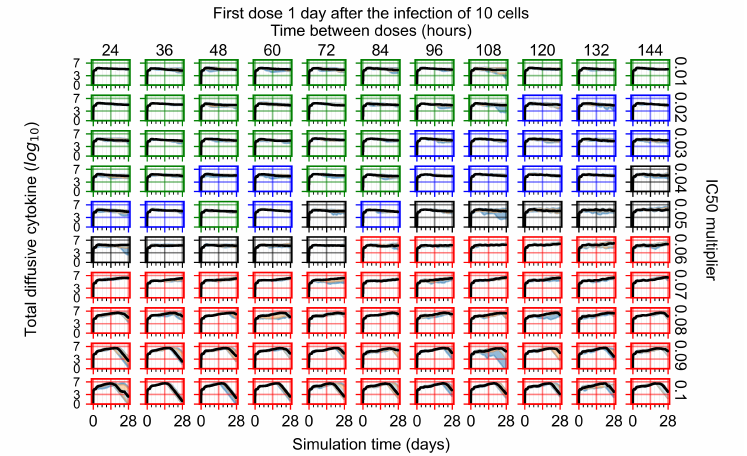
Figure A114. Diffusive cytokine amount for eight replicas of the treatment simulation, Y axis in log scale, and exponent values as tick marks.